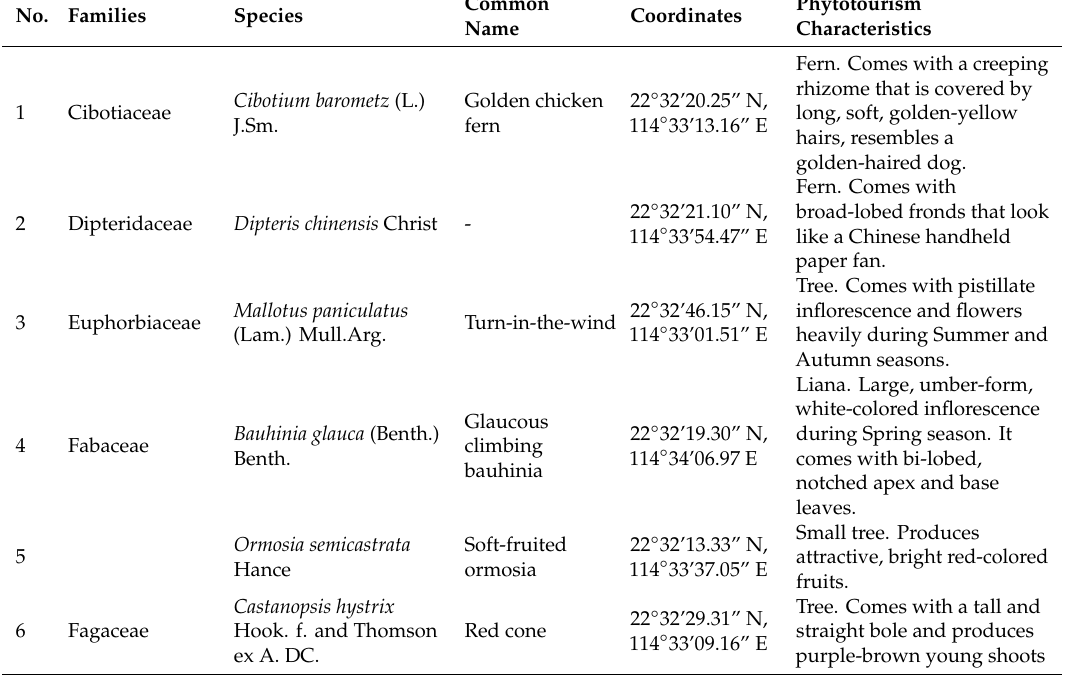
Table 4. Vascular plants and scenic spots recorded along the trail that are suitable as phytotourism products and aesthetic features to the hiking experience. The locations of the plants and scenic sports are plotted on the study site map developed from the aerial observation in Figure